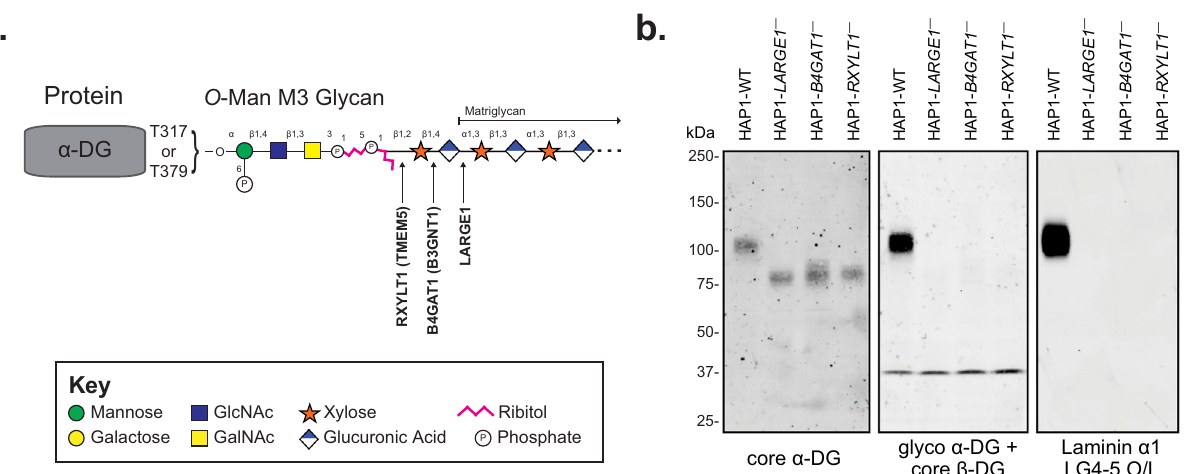
mannosides (Man) and N -acetylgalactosamine (GalNAc) initiat- ing glycans, only three sites (T317, T319, and T379) carry receptors for LG-containing proteins. These sites are modi fi ed by a functionally relevant O -Man core M3 glycan that so far has only